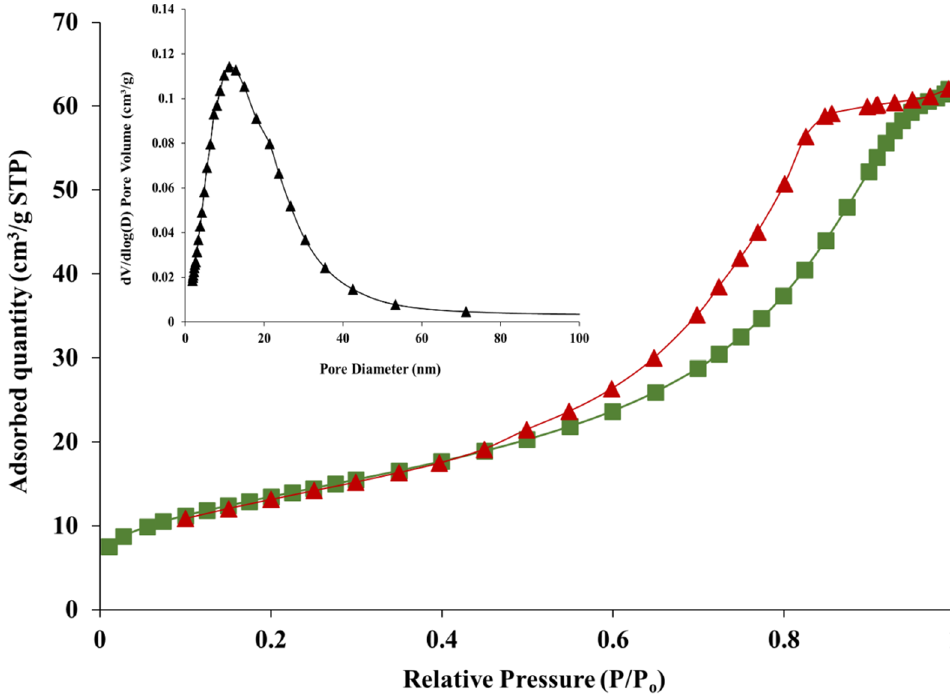
Figure 8. N 2 adsorption–desorption graph with a variation of pore diameter with respect to